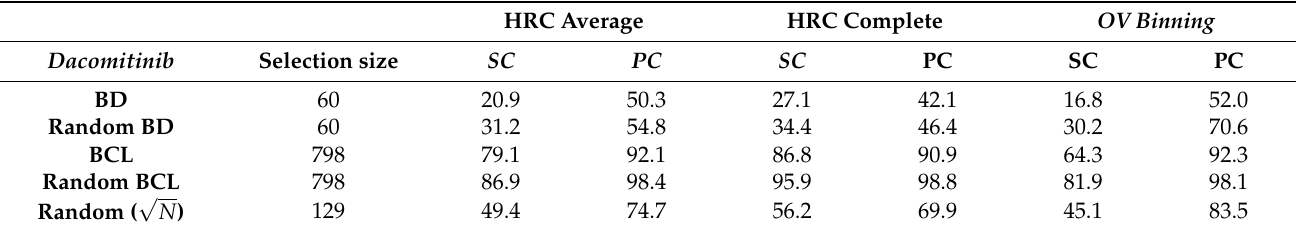
√ N clusters for Dacomitinib analogs.